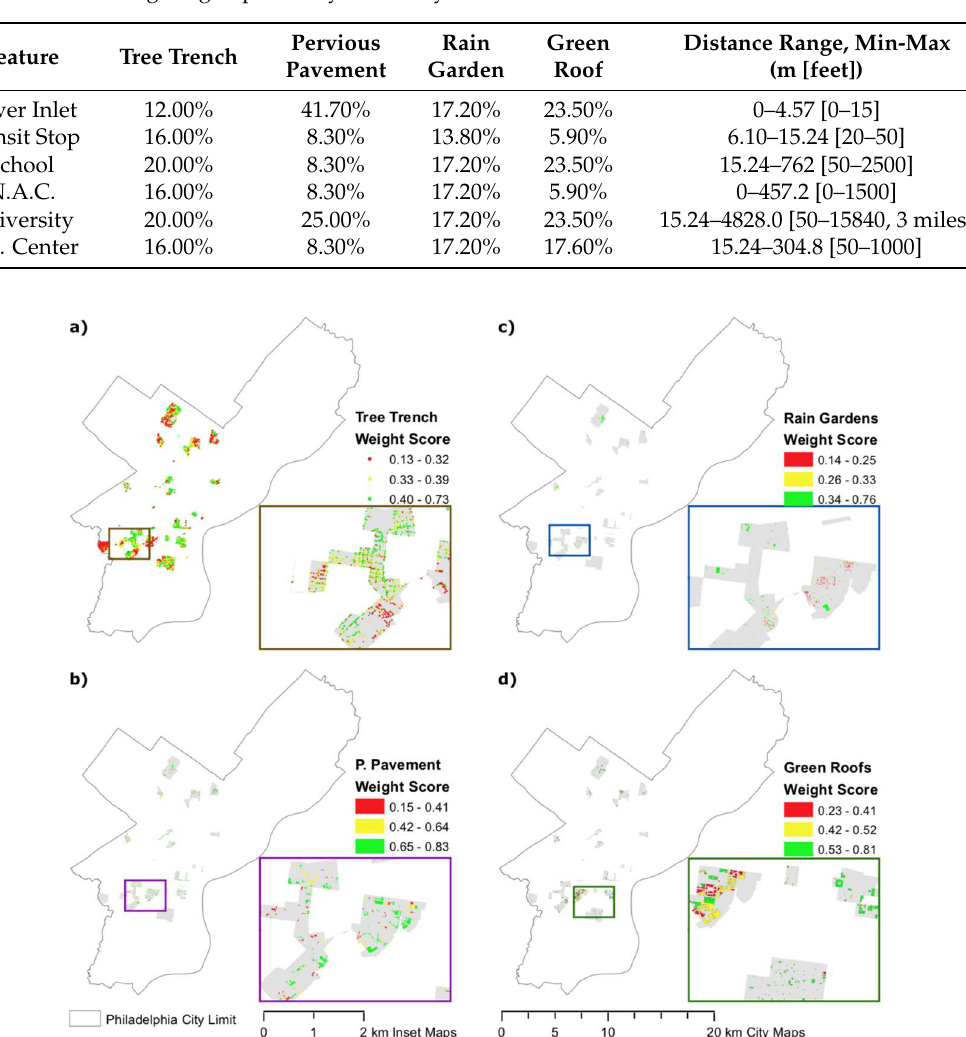
Table 1. Weighting of proximity to socially relevant features and their functional distances.